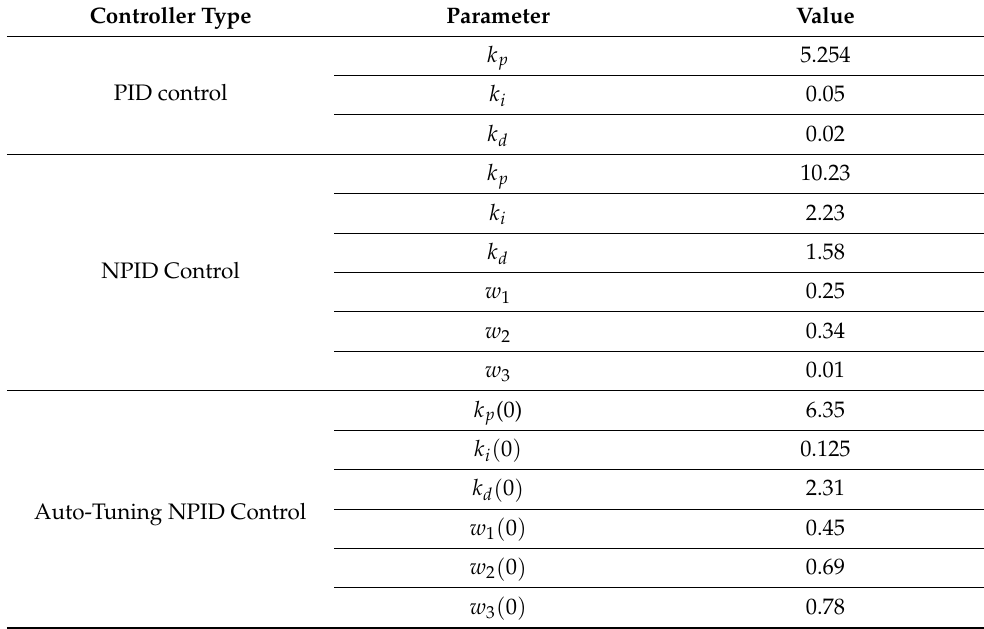
Table 3. Uncertainty parameters of the EV